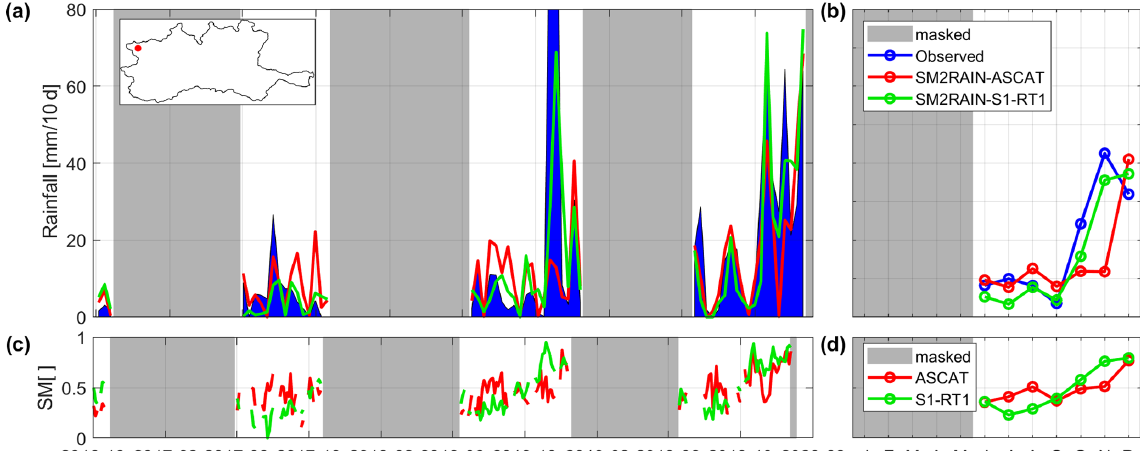
Figure 5. Example of SM and rainfall time series over a pixel (7.152 ◦ E, 45.710 ◦ N) where the parameterized SM2RAIN applied to S1-RT1 outperforms SM2RAIN-ASCAT. In (a) , the time series of the observed (blue) and estimated (red SM2RAIN-ASCAT, green SM2RAIN-S1- RT1) 10d accumulated rainfall products are shown, while panel (c) displays SM time series averaged with a 3d window. Finally, panels (b) and (d) contain the standard month average of the rainfall and SM products, respectively. The periods masked for frozen soil conditions or snow cover are highlighted in grey.